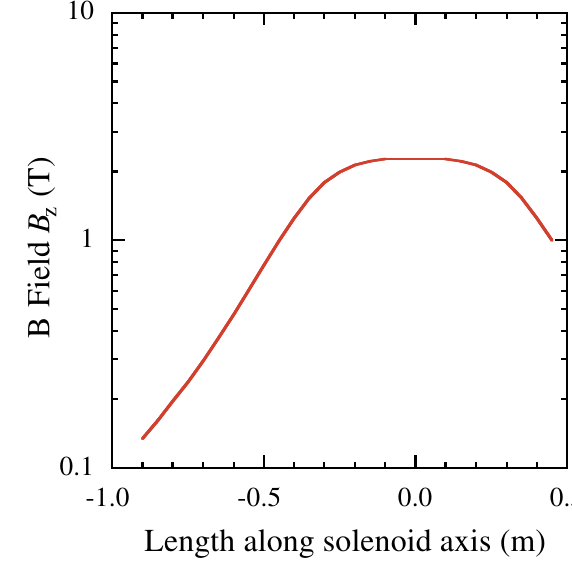
FIG. 20. (Color) The solenoidal field on axis in the cavity.